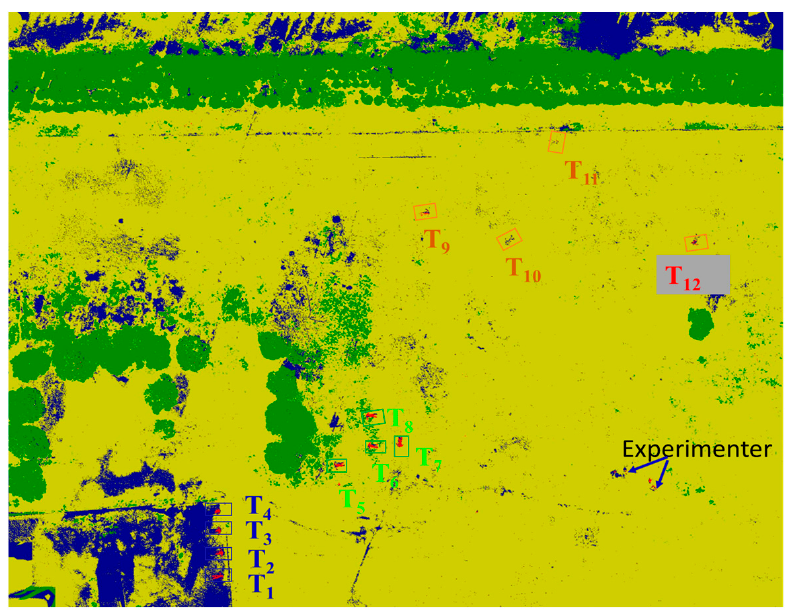
Figure 14. The complete reflectance panorama in Scenario 2.